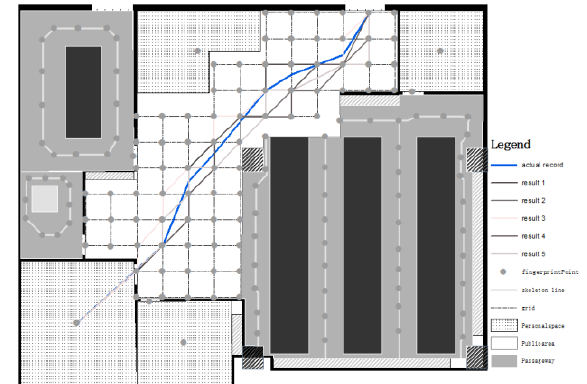
Figure 5 Efficiency and Accuracy Testing